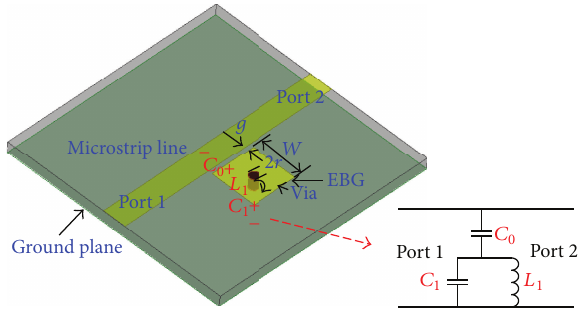
Figure 1: 3D overviews and equivalent-circuit model of EBG.